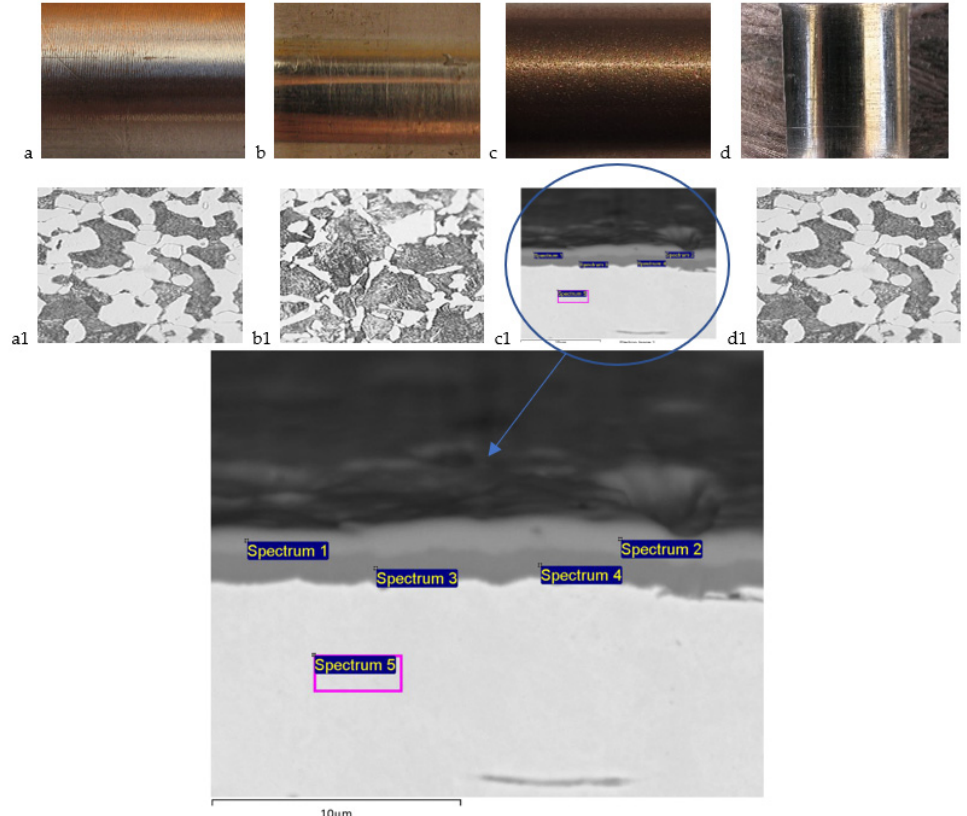
Figure 2. View of the surface of shafts and sleeves under analysis and their top layer: ( a ) shaft without additional treatment, ( b ) rolled shaft, ( c , c1 ) shaft with the TiSiN coating, ( d ) sleeve, ( a1 ) microstructure of the shaft surface layer without additional treatment, ( b1 ) microstructure of the surface layer of a rolled shaft, ( c1 ) cross section of the shaft with TiSiN coating, ( d1 ) microstructure of the top layer of the sleeve.